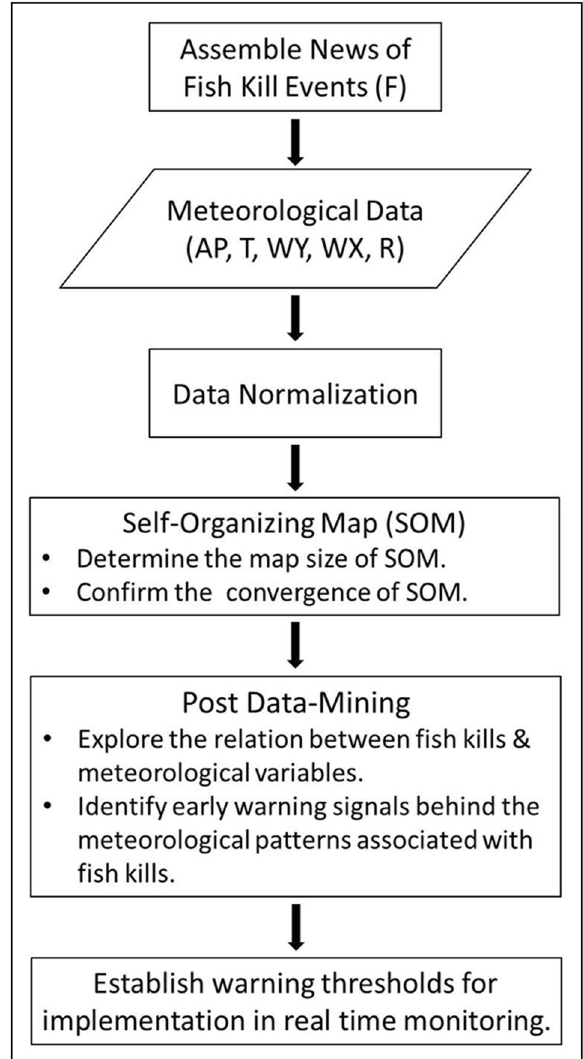
Figure 6. Flowchart of this